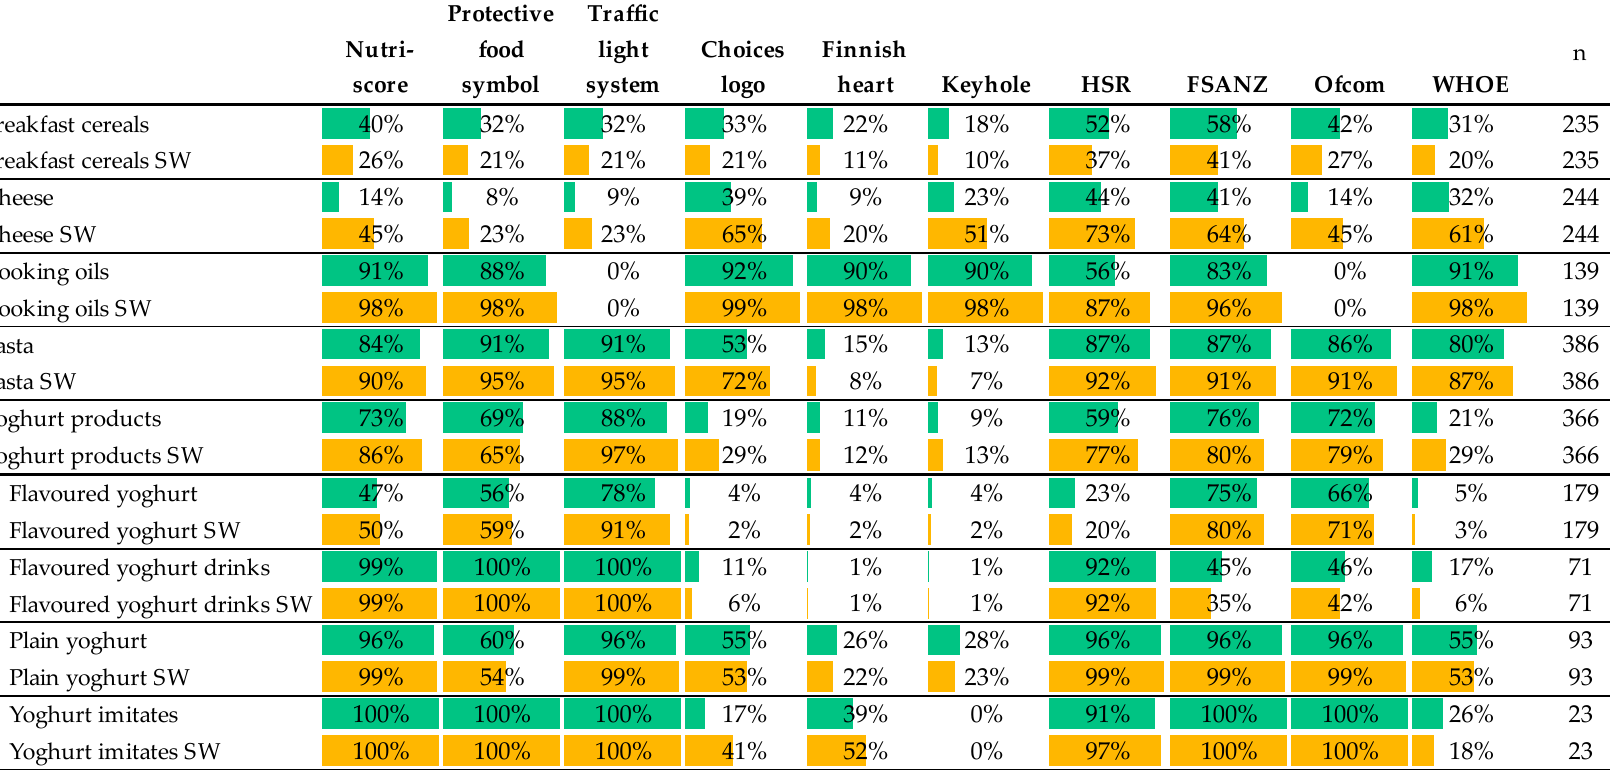
Figure 1. Proportion and sales-weighted (SW) proportion of product that are defined as »healthier foods« by different nutrient profiling models.